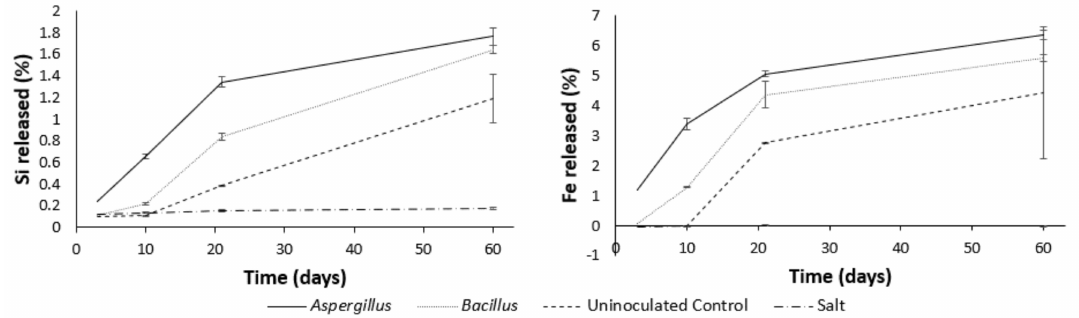
Figure 3. Changes in leaching of Si and Fe with time. Error bars are standard deviation of